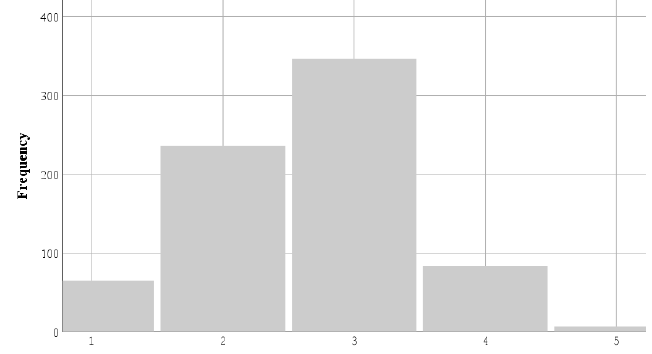
Figure 1: Histogram of impact of social media use in activity and mobility